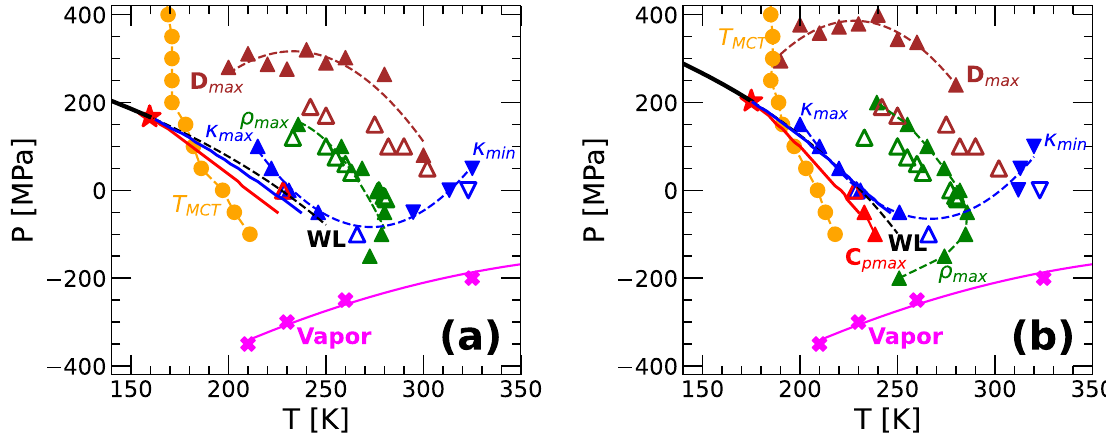
Figure 7. Phase diagram of q-TIP4P/F H 2 O obtained from ( a ) PIMD/RPMD and ( b ) classical MD simulations. The black solid and dashed lines are, respectively, the LLPT and Widom lines obtained from the TSEOS; the filled red star is the LLCP from the TSEOS. The red and blue solid lines are the C P -maxima and κ T -maxima line from the TSEOS. The magenta crosses represent the vaporization line where the liquid spontaneously cavitates during the computer simulations. The green up-triangles are the density maxima. Blue up and down triangles represent, respectively, the maxima and minima in the isothermal compressibilities; red triangles indicate the maxima in C P . Brown up-triangles are the maxima in the diffusion coefficient; orange circles represent the MCT temperature (see Eq. 5). Experimental data are shown by empty triangles 5,19,71,78–80 ; filled symbols are results from MD/PIMD simulations. The estimated location of the LLCP based on experiments is ( T c = 220 K, P c = 50–100 MPa) 12